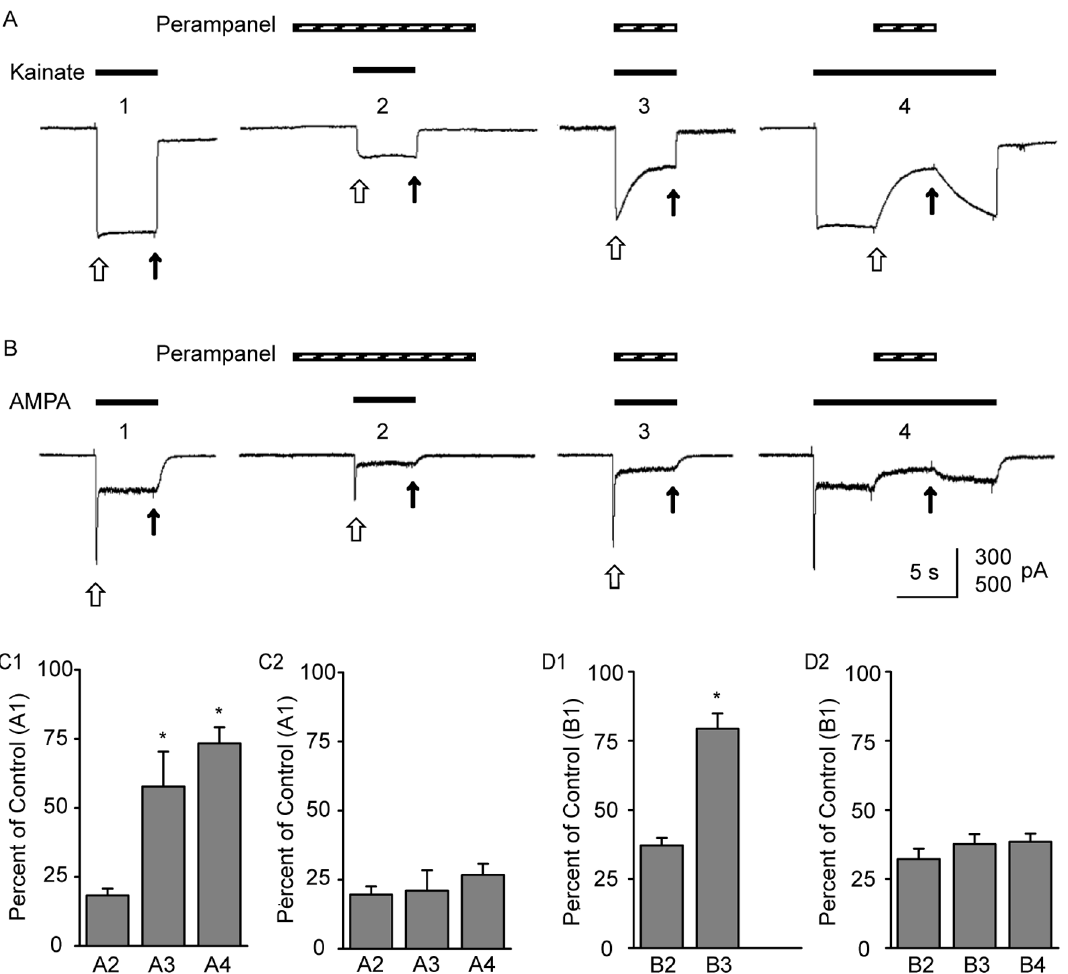
Figure 3. Slow onset and recovery from perampanel block of kainate- and AMPA-evoked currents. (A) Currents evoked by 100 m M kainate in the absence (A1) and with pre-application (A2), co-application (A2) and post-application (A3) of perampanel (3 m M) in the same neuron. (B) Currents evoked by 100 m M AMPA in the absence (B1) and with pre-application (B2), co-application (B2) and post-application (A3) of perampanel (3 m M) in a different neuron from (A). Open arrows indicate peak current levels in the case of AMPA-evoked currents and the current at 100 ms after onset of agonist application in the case of kainate-evoked currents; closed arrows indicate late current levels (end of agonist application). Scale for current is 300 pA in (A) and 500 pA in (B). (C) Mean 6 S.E.M. values of peak (C1) and late (C2) current levels as a percent of control (as in A1) with perampanel pre-application (as in A2), co-application (as in A3) and post-application (as in A4) in 3–4 neurons (D) Mean 6 S.E.M. values of peak (D1) and late (D2) current levels as a percent of control (as in B1) with perampanel pre-application (as in B2), co-application (as in B3) and post-application (as in B4) in 4 neurons. * p , 0.05 vs. A2 or B2.